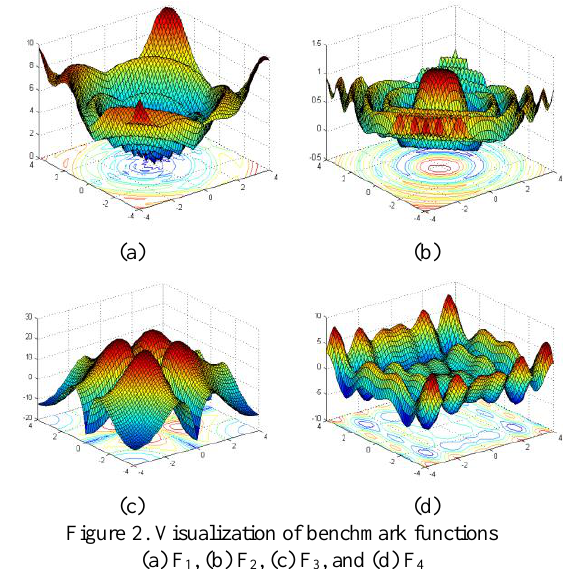
Figure 2. Visualization of benchmark